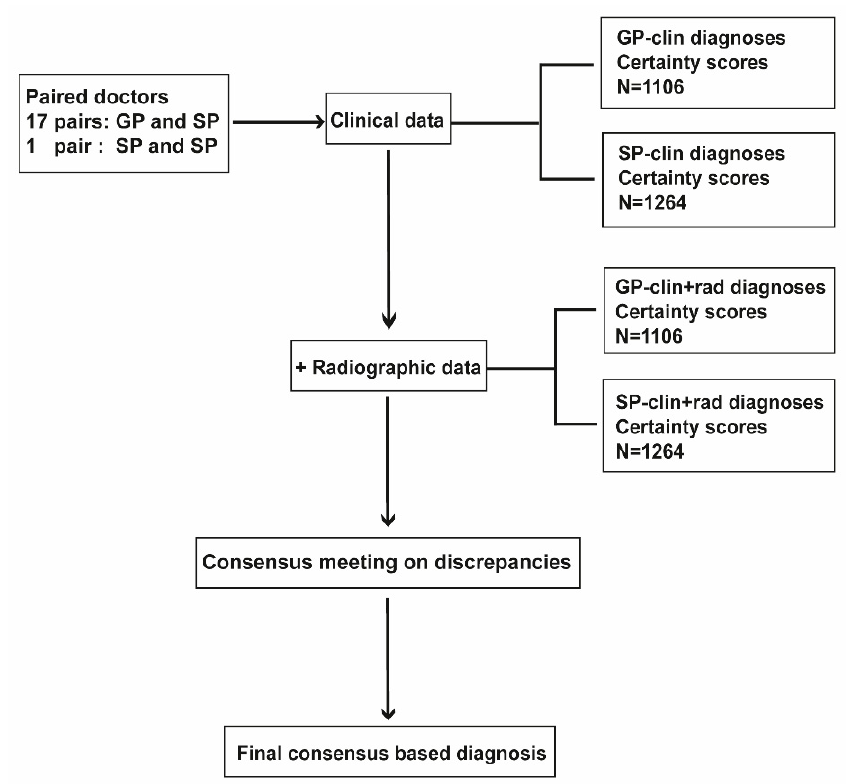
Figure 1. Diagnostic process. OA, osteoarthritis; GP, general practitioner; SP, secondary care physician; Clin diagnosis, diagnoses based on clinical data only; clin + rad, diagnoses based on clinical and radiographic